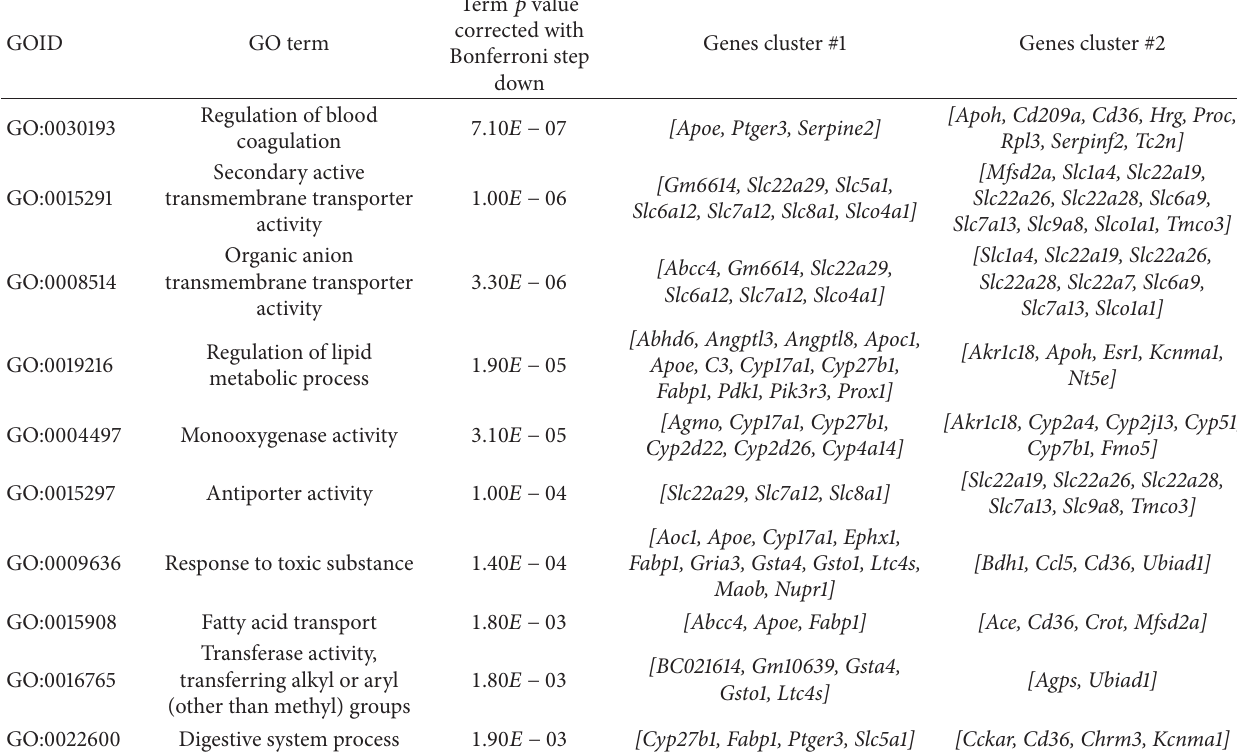
Table 2: Top 10 enriched GO terms for DEGs sorted by 𝑝 value (ascending).